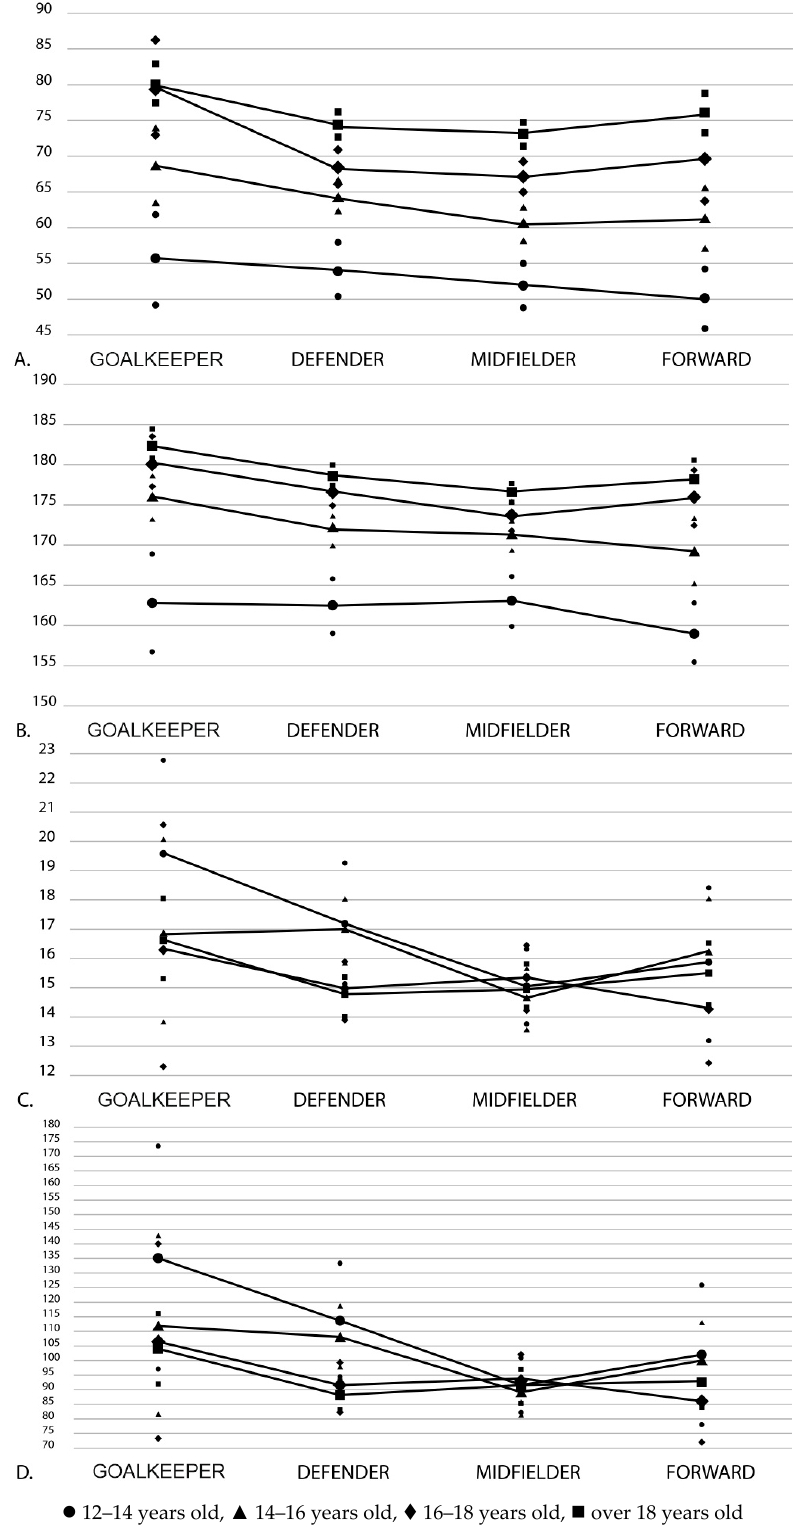
Figure 1. Means (CI 95 %) of the anthropometric variables ( A ) weight; ( B ) height; ( C ) % body fat; ( D ) sum of skinfolds) by age group and playing position.